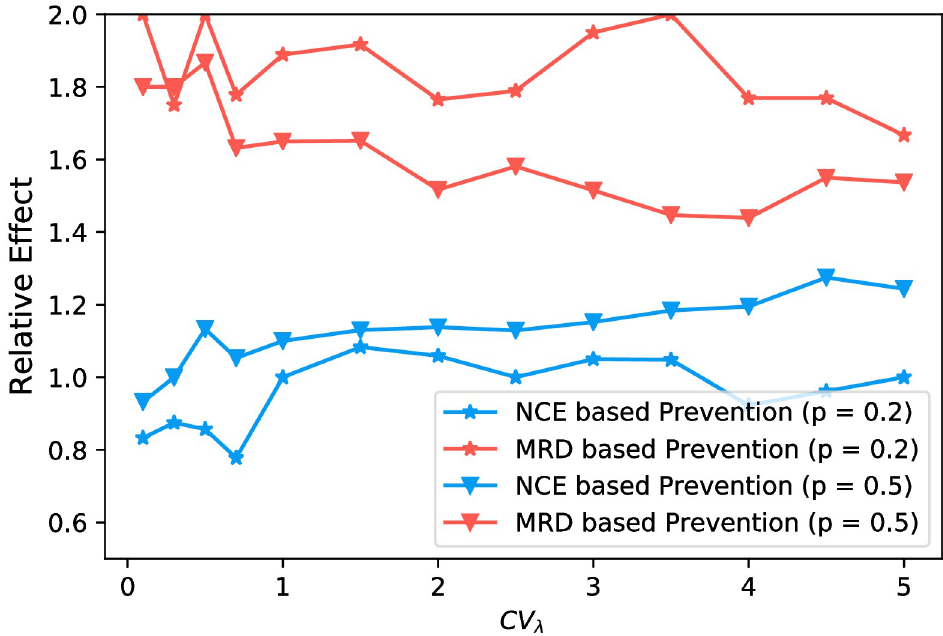
Fig 11. Relative effect of NCE -based strategy (blue lines) and MRD strategy (red lines) over random prevention under the situation of Cross-sectional prevention. The fraction of contact traced is fixed as p = 0.2 (lines with 5 ) and p = 0.5 (lines with ?